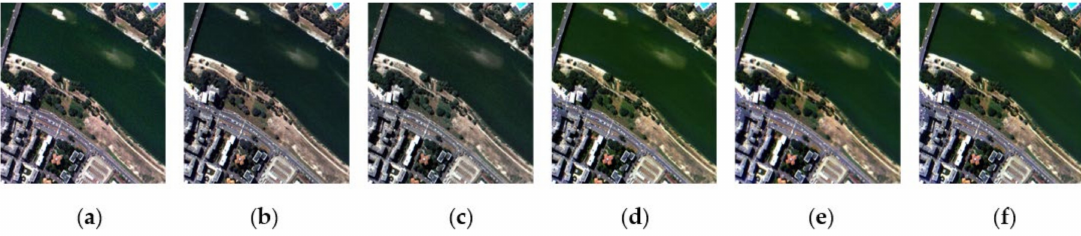
Figure 3. Fused images of Pavia City Center. ( a ) CNMF; ( b ) JNMF; ( c ) DPLM; ( d ) TCNNF; ( e ) DiCNN; ( f ) CpNN.